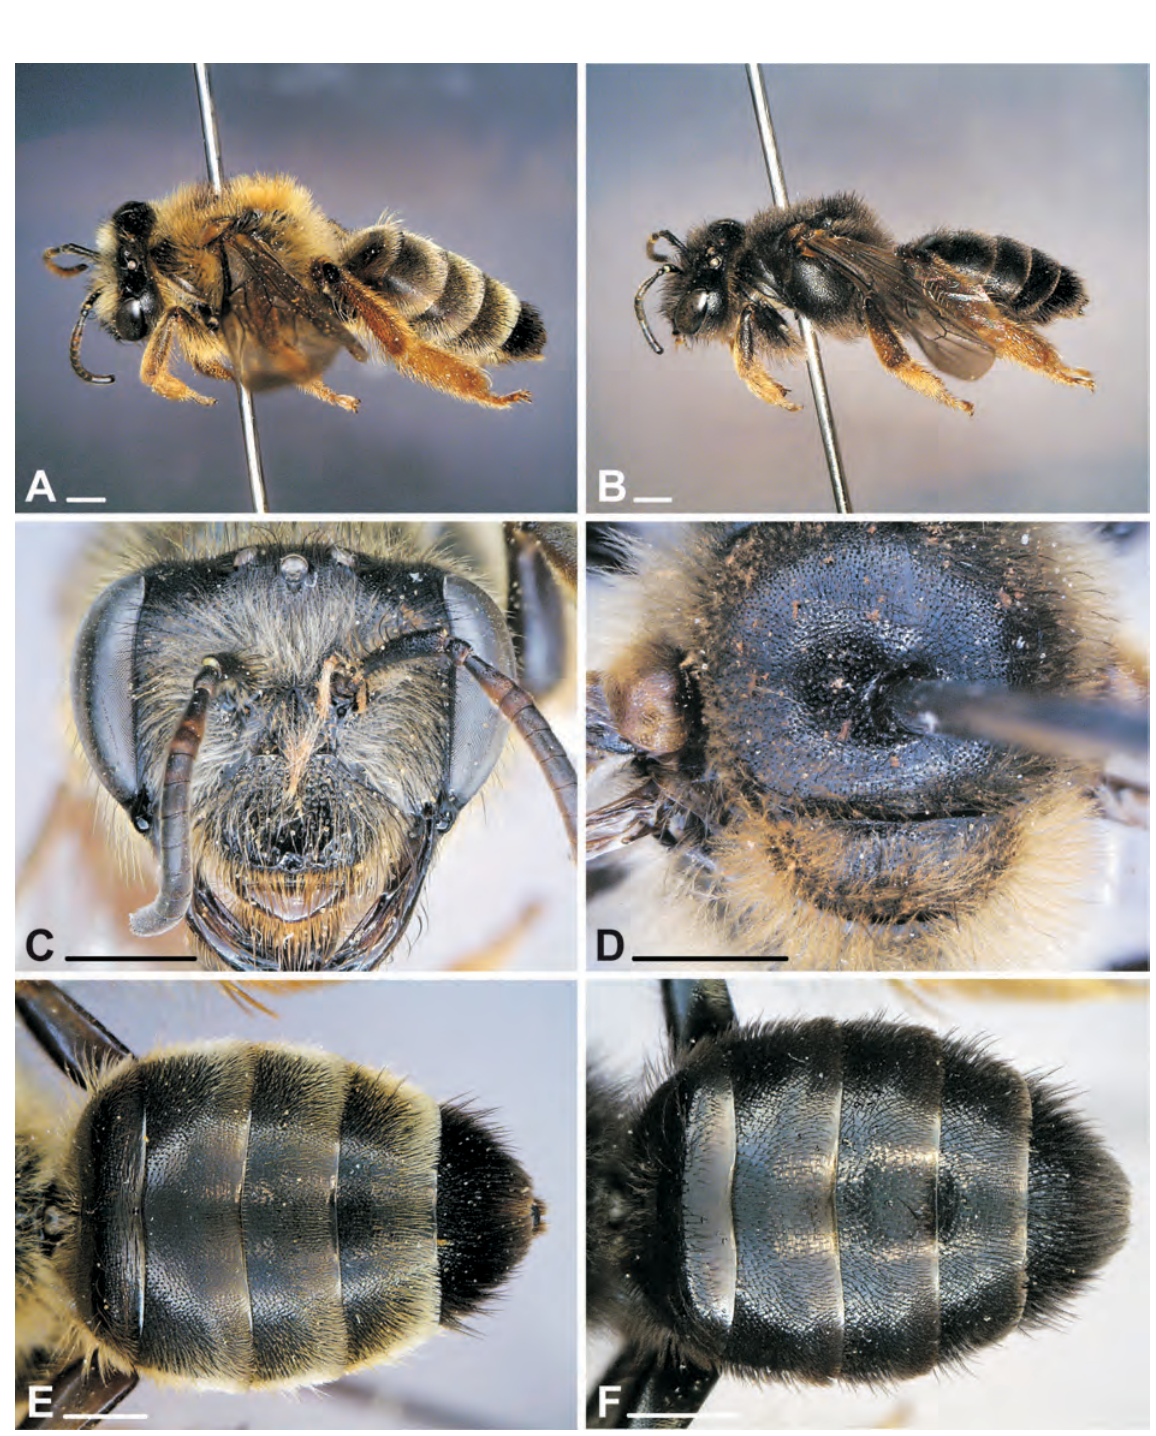
Fig. 15. Redivivoides variabilis sp. nov., ♀. A . lateral view (light form). B . lateral view (black form). C . head. D . Scutum and scutellum. E . Metasoma (dorsal view) (light form). F . Metasoma (dorsal view) (black form). Scale bar: 1